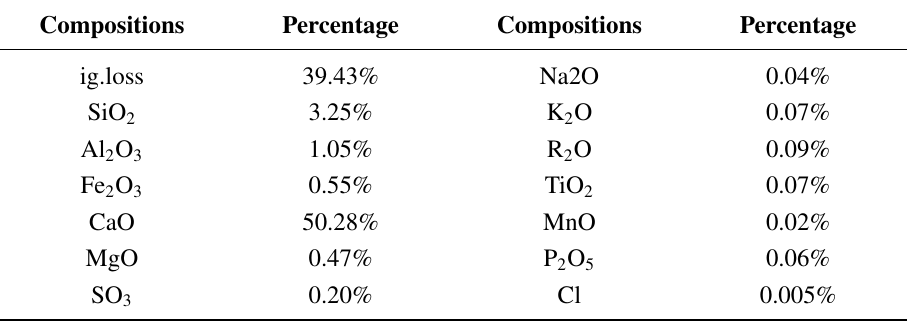
Table 5. Chemical compositions of the hardened fly ash concrete.